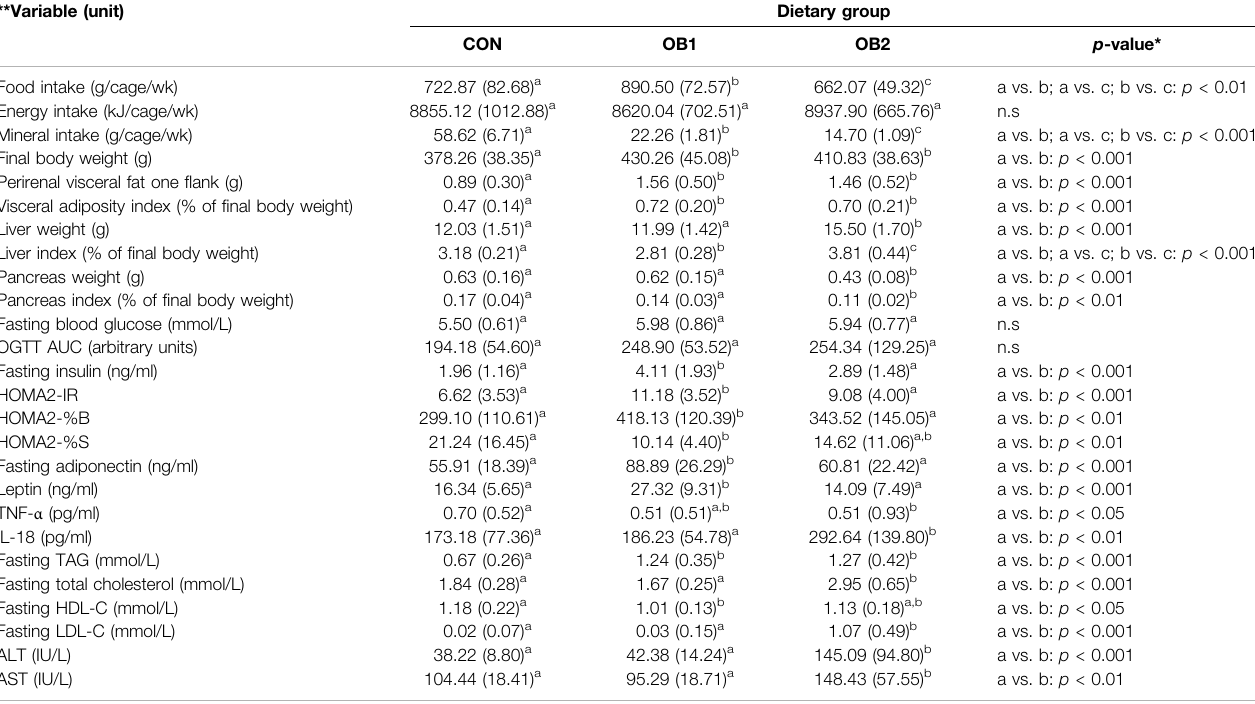
TABLE 2 | Food and energy intake and metabolic characteristics (end-point analysis) for each dietary group. **Variable